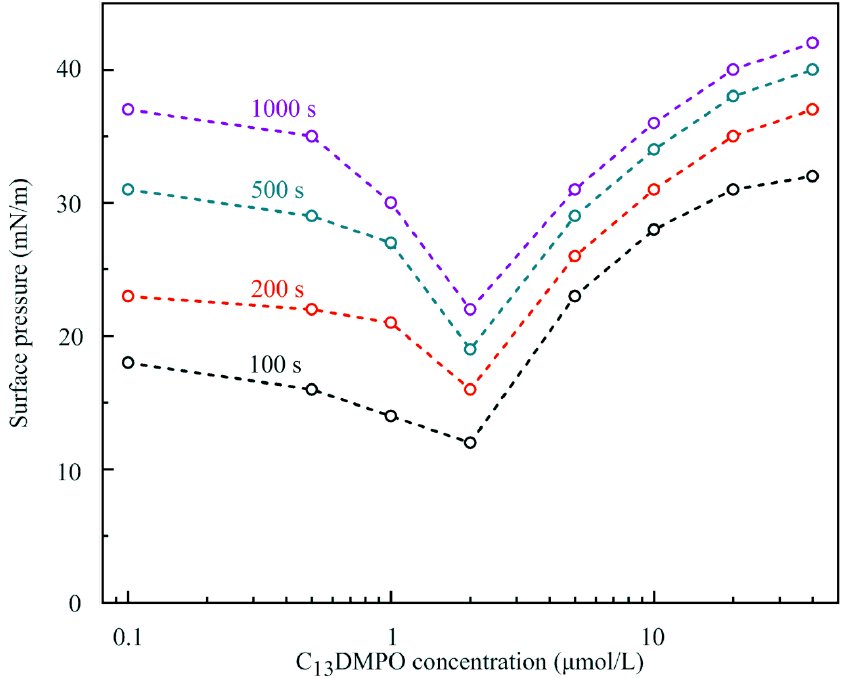
Figure 12. The same as in Fig. 11 for C 13 DMPO solutions.